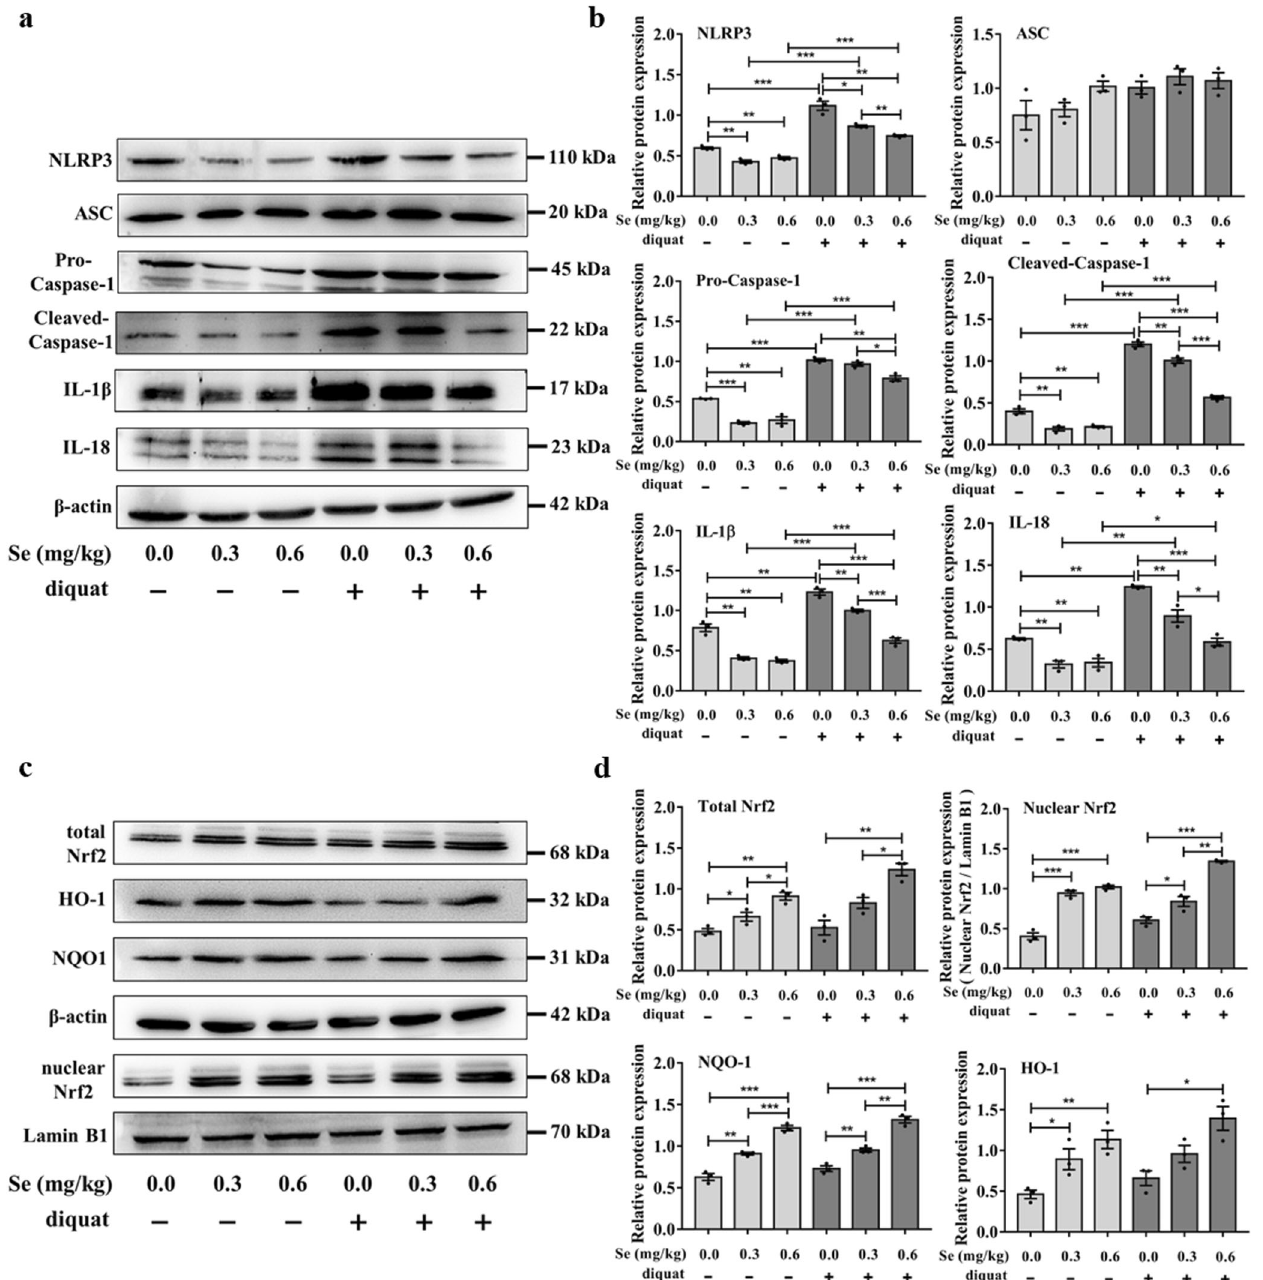
Fig. 6 The Nrf2 signaling pathway inhibits the diquat-induced NLRP3 in fl ammasome activation in the jejunum. a The expressions of the NLRP3 in fl ammatory proteins were measured by Western blot analysis ( n = 3). b Quantitative analysis of the protein expression levels of NLRP3, ASC, pro-caspase 1, cleaved-caspase 1, IL-1 β , and IL-18. c Nrf2 activation and expression levels of its downstream proteins were measured by Western blot analysis ( n = 3). d Quantitative analysis of the protein expression levels of total Nrf2, nuclear Nrf2, HO-1, and NQO- 1. Data are expressed as mean ± SEM. * P < 0.05; ** P < 0.01; *** P < (the levels of in fl ammatory cytokines and antioxidant capacity in supranutritional Se increased the content of total SCFAs, butyrate, jejunum) was generated to identify the potential correlation isobutyrate, valerate, and isovalerate (Fig. 5l). Subsequently, using between Se-induced gut microbiota changes and intestinal barrier PICRUSt2 software and the KEGG database, we analyzed the dysfunction. As shown in Fig. 5m, Allobaculum was negatively difference and changes in metabolic pathways of functional correlated with the antioxidant capacity including T-AOC, GPx, and genes of the gut microbiota. The enriched functional categories in TrxR, while Helicobacter was positively correlated with the the 0.6-Se group included “ Human Diseases ” at the KEGG level 1 activities of T-AOC, GPx, and TrxR. Moreover, Helicobacter and and “ Digestive system ” at the KEGG level 2 (Supplementary Bacteroides were positively correlated with the level of sIgA, but Figs. 5 and 6). negatively correlated with Allobaculum . In addition, for SCFAs, A heatmap of Spearman correlation between the altered genera Helicobacter was positively correlated with total SCFAs, butyrate, and intestinal barrier dysfunction-related biochemical indexes